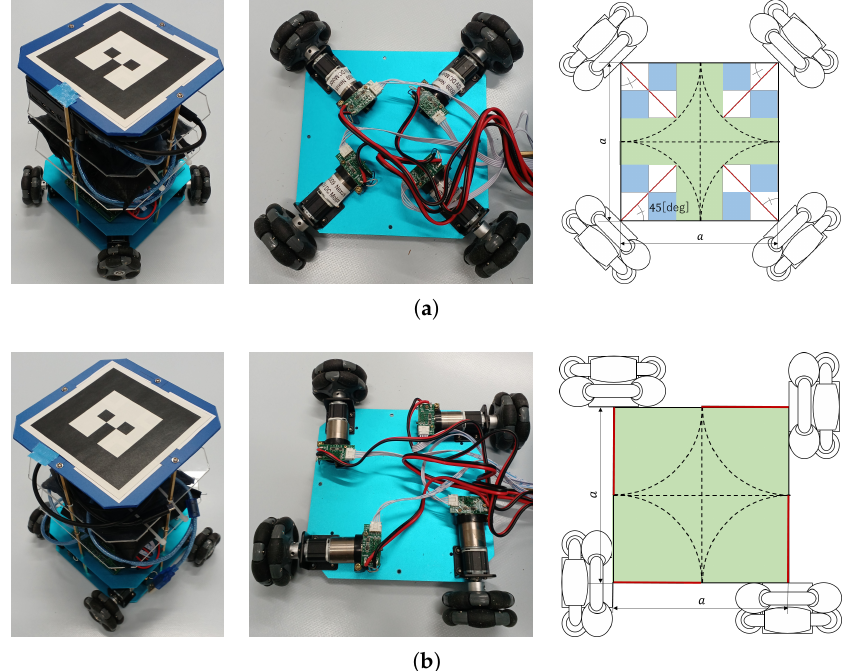
Figure 4. Appearance and schematic diagram of the robots: The left side shows the robot’s appearance, the center shows the actual wheel arrangement, and the right side shows a conceptual diagram representing the area where parts can be placed. ( a ) Robot hardware with conventional arrangement; ( b ) robot hardware with proposed